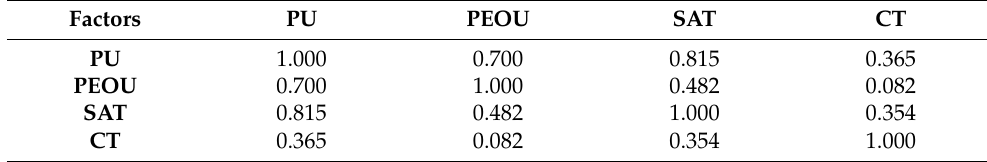
Table 5. Correlations of